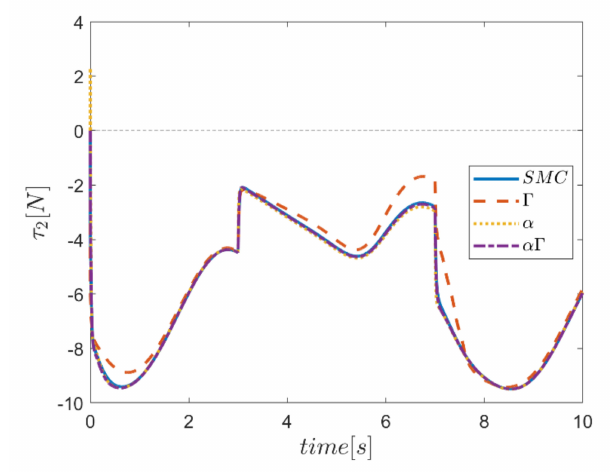
Figure 51. Comparison of the input force in the second actuator.